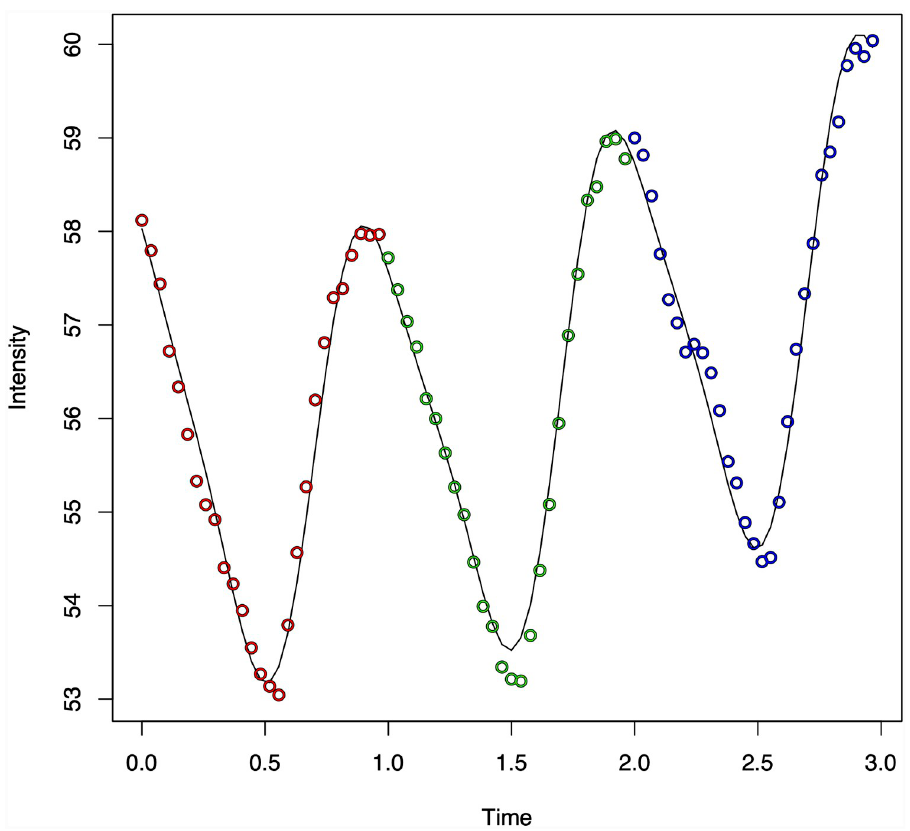
Fig 2. Harmonic regression model fit in a single case. The periodic nature of the data and harmonic regression model fit from the green channel from three cardiac cycles is demonstrated in the retinal vein from a single case. The changes in the harmonic regression waveform with changes in ODF are detailed in Figs 9 to